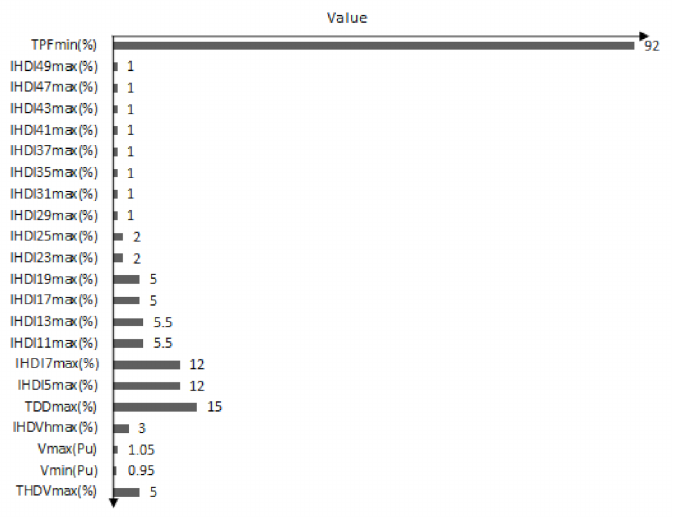
Figure 6. The threshold values according to the IEEE 519.